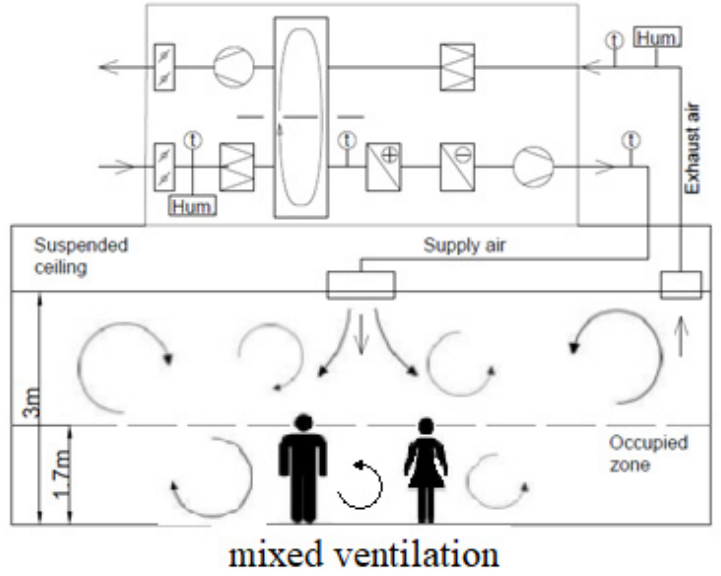
Figure 3. Swirls caused by the type of ventilation (schematic mode of the laboratory).